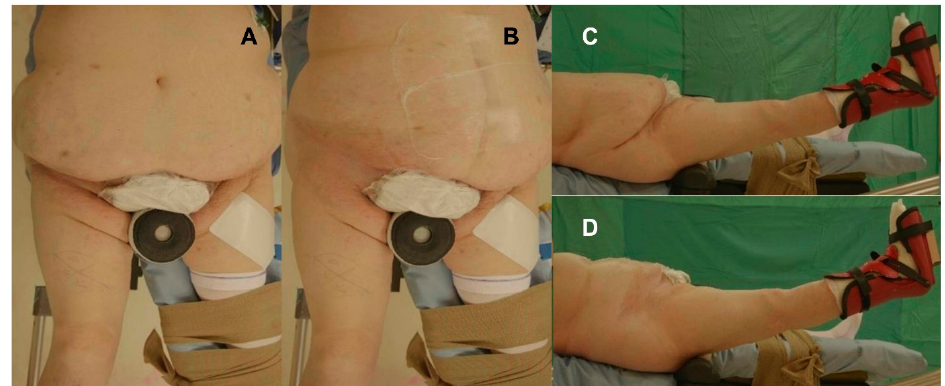
Figure 2. ( A ) Coronal view of patient positioning on the traction table to perform THA via DAA. ( B ) Coronal view, in which adipose tissue is displaced from the point of incision with an adhesive drape. ( C ) Sagi tt al view of patient positioning on the traction table; the leg is placed in a boot and is positioned with the leg at 30° of fl exion, with neutral abduction and rotation. The belly fat is placed over the incision site. ( D ) Sagi tt al view, in which the incision site is free; adipose tissue is moved on contralateral side with adhesive drape.